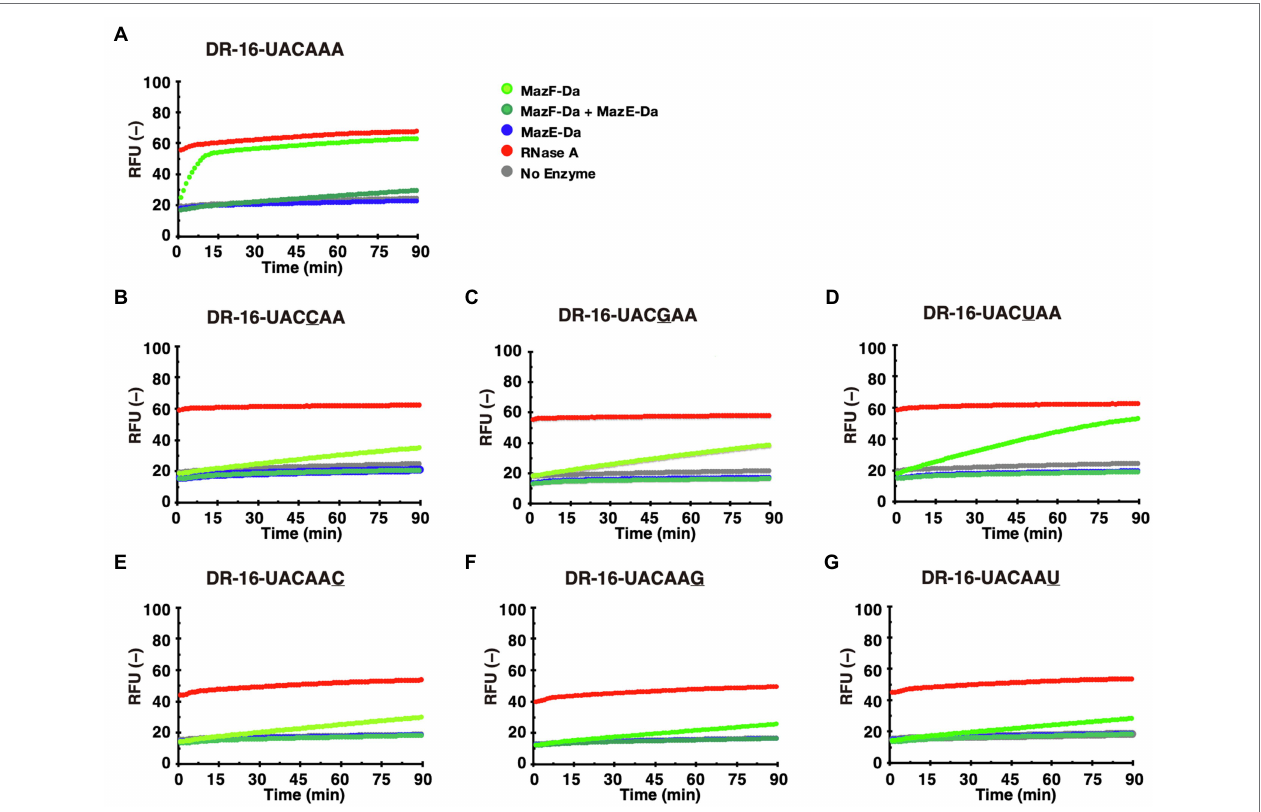
FIGURE 4 | Identification of the MazF-Da cleavage sequence. MazF-Da (light-green), MazE-Da (blue), or MazF-Da preincubated with MazE-Da (green) were reacted with each of the following fluorescent probes (A–G) : (A) DR-16-UACAAA, (B) DR-16-UACCAA, (C) DR-16-UACGAA, (D) DR-16-UACUAA, (E) DR-16- UACAAC, (F) DR-16-UACAAG, (G) DR-16-UACAAU. Fluorescence intensities in the presence of RNase A (red) and in the absence of enzymes (gray) were continuously assessed as control